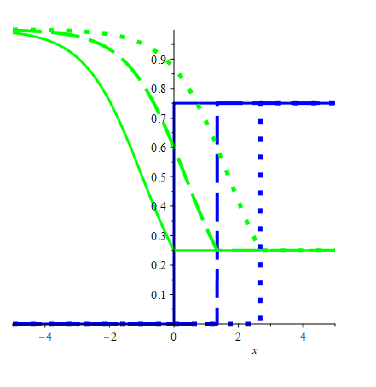
Figure 1. The figure shows the propagation of waves (43)–(45) calculated for the Lotka–Volterra kinetics (40) (from the left to the right). Each frame shows three instantaneous profiles for both the predator and the prey densities. In the left and middle frames, the blue (green) coloured lines are for the former (latter), while the solid, dashed and dotted lines picture the profiles taken at t = 0, t = 3/2 and t = 3. The right frame addresses the wave that transports a patch filled with the unit mass of predators. At that, the dashed (solid) lines mark out the densities of the predators (prey). The colours green, red and blue are for the shots taken at t = 0, t = 3/2 and t = 3 (so that the wave speed is negative). All three panels correspond to the Lotka–Volterra kinetics (40), where α = 1, β = 0.2, γ = 0.8. At that, the diffusivity function reads as µ = ( 1 + s ) − 1 , so that κ = 1, and the equality (27) (cid:112) µ ( s e ) ≈ 0.9. Finally, recall determines the sensitivity, χ . These definitions give the wave speed, c = that the figure regards the diffusionless and inertial limit, and δ = ν = 0,